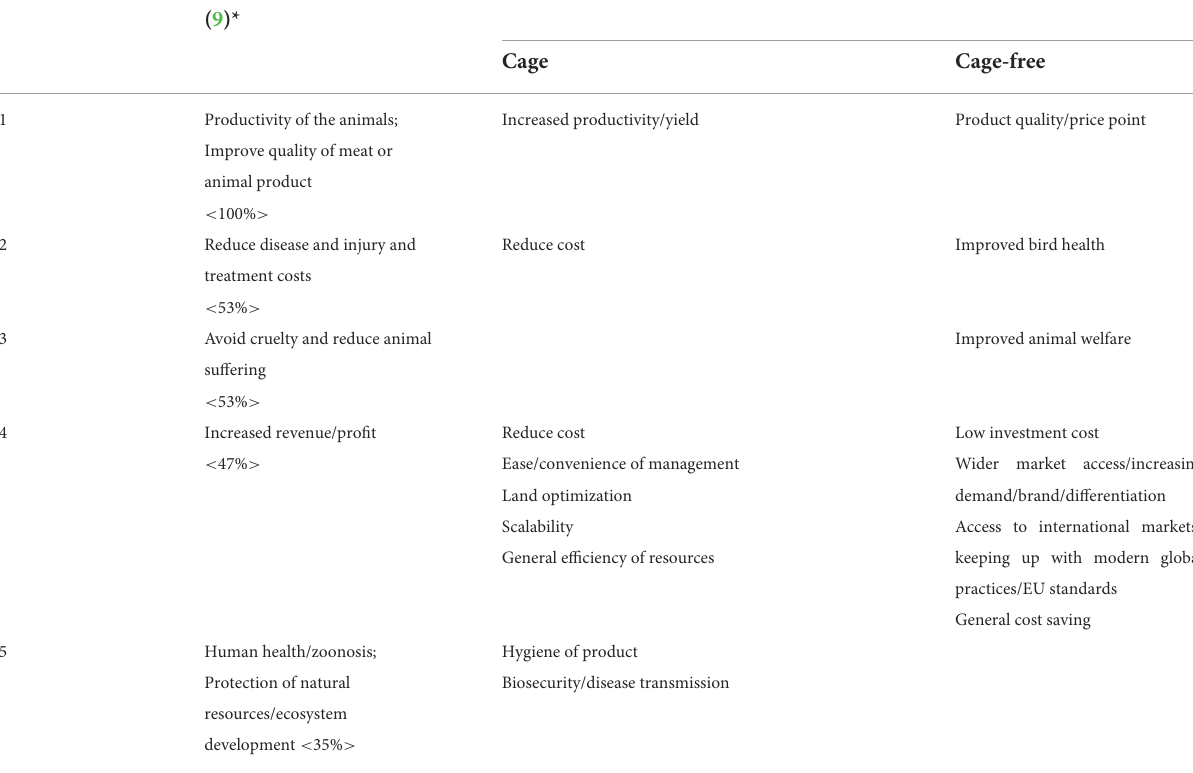
TABLE 7 Comparison of the perceived benefits in improving animal welfare in a previous study with livestock leaders in Asia (9) in relation with Asian egg producers in the present study. Rank* Benefit by “importance” Comparative benefit “top 10” findings in present study (2022)** (9)* Cage